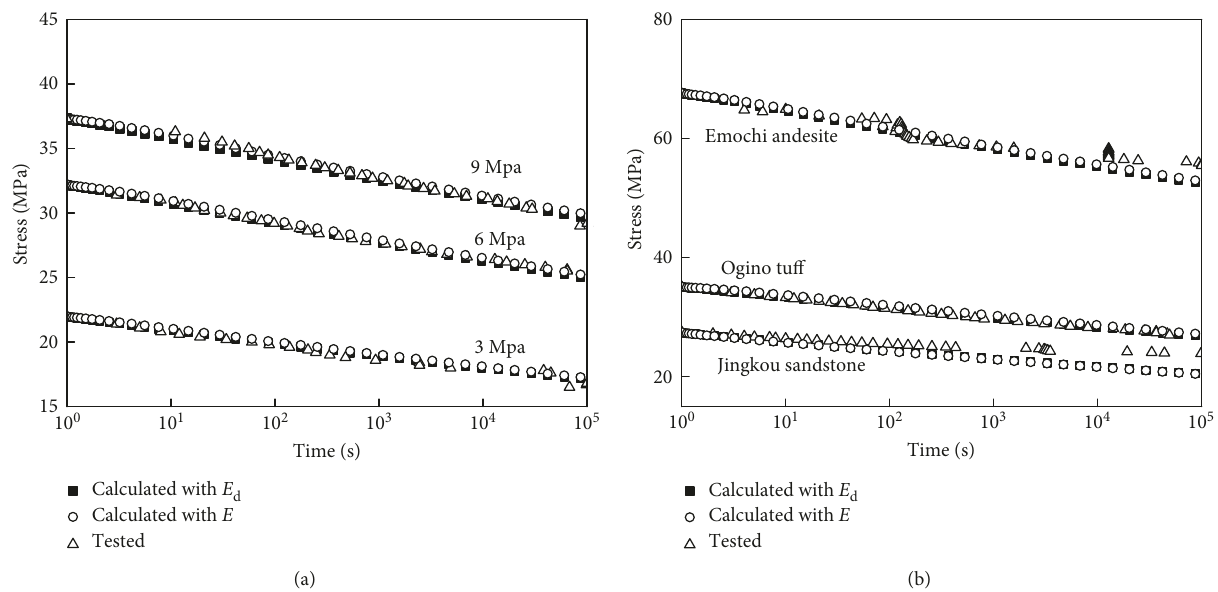
Figure 13: Comparison of experimental and calculated results of stress relaxation in the postfailure region for (a) Tage tuff, (b) other